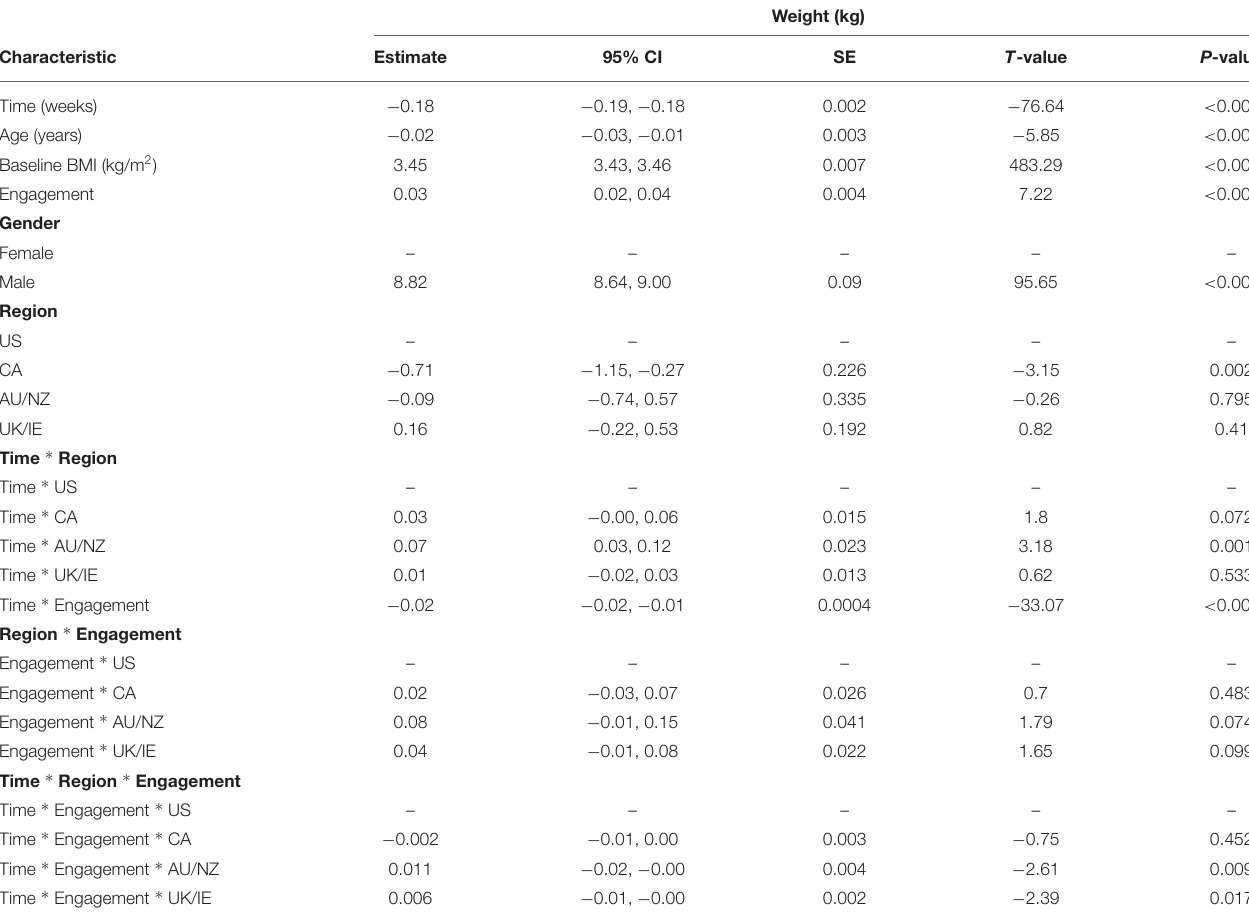
TABLE 3 | Summary of linear mixed model results.